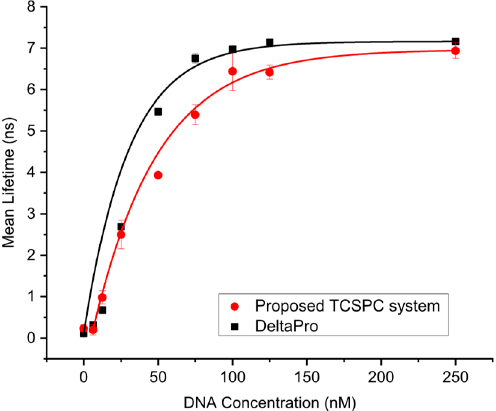
Figure 10. Mean and standard deviation of extracted fluorescence lifetimes across DNA concentrations, from both the proposed system and the DeltaPro.